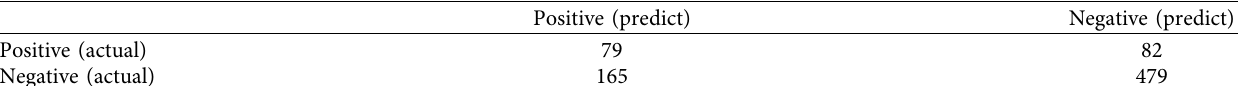
Figure 9: ROC curve and AUC values of the model were established for the two sets of data. Table 8: The high precision data set model is applied to the low precision data set.